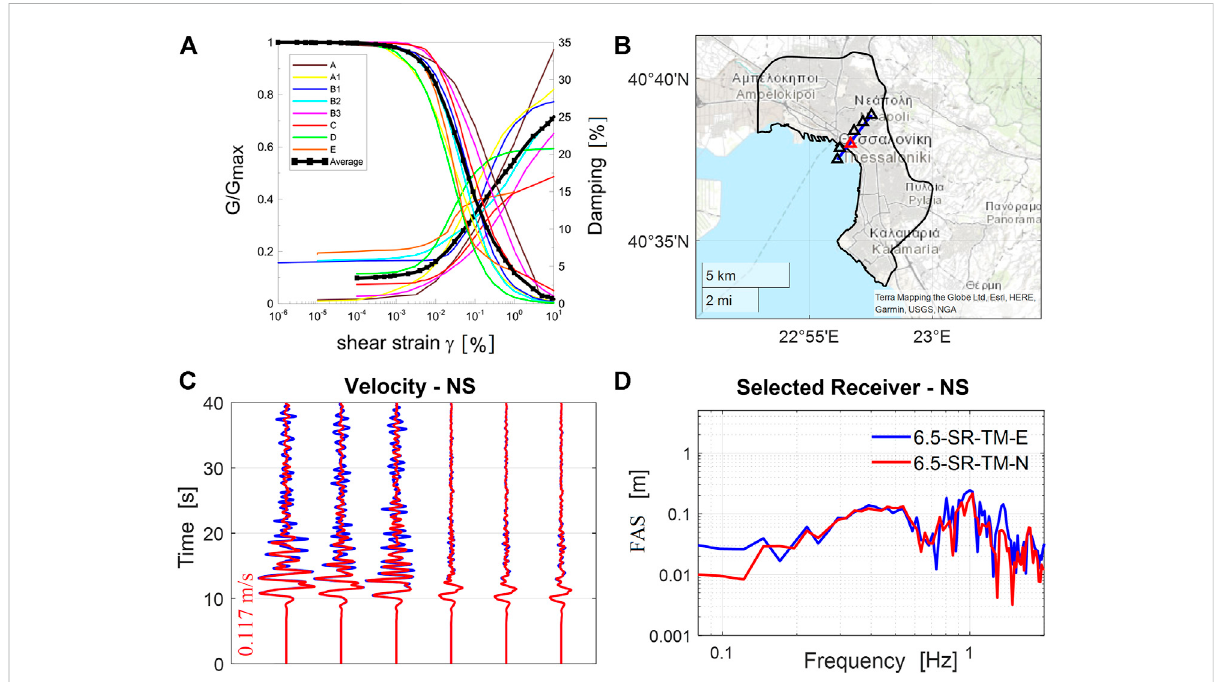
FIGURE 8 (A) G/G max - γ and D- γ curves (from Smerzini et al., 2017). (B) A set of receivers (triangles) along a representative cross-section across Thessaloniki. (C) Comparison of velocity time histories (NS component) computed using a linear and non-linear elastic soil model for the set